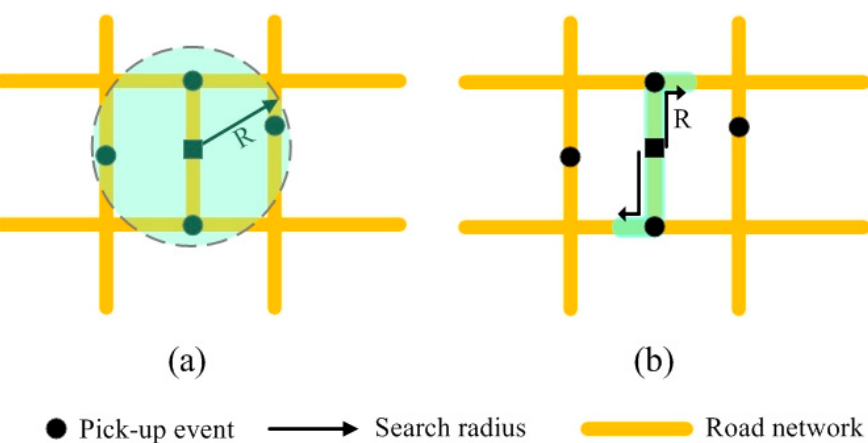
Figure 3. Comparison of the search radius measured by Euclidean distance ( a ) and network path distance ( b ).